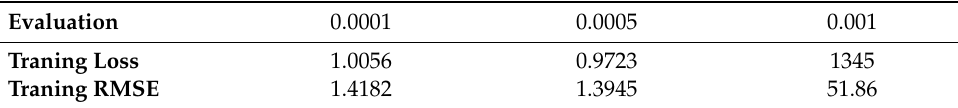
Table 6. Ablation study of different learning